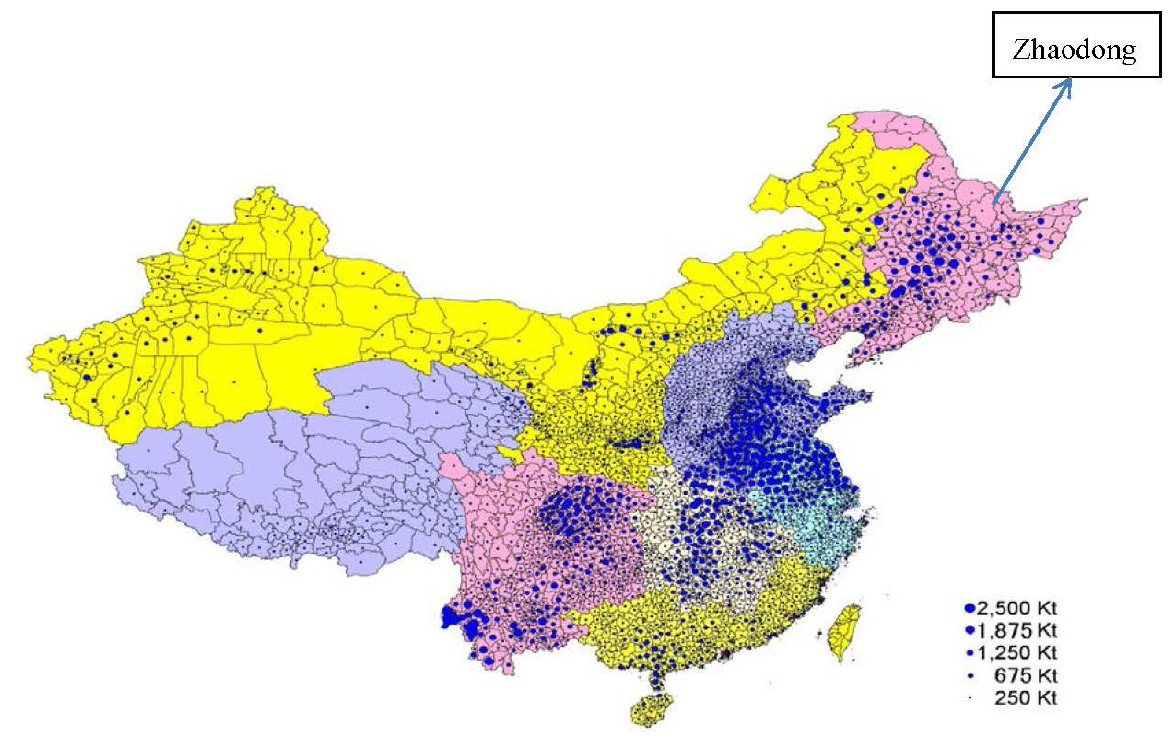
Figure 4. China’s crop residue distribution in kilo tonne.